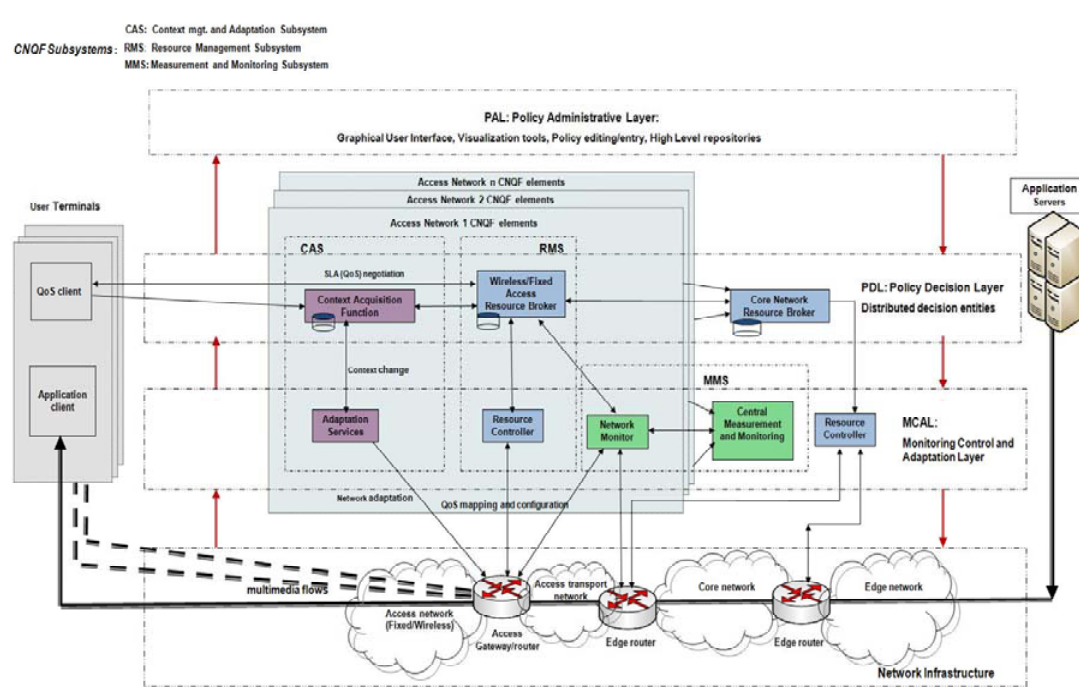
Figure 1. Converged Networks QoS Management Framework (CNQF) subsystems and operational entities in a converged network